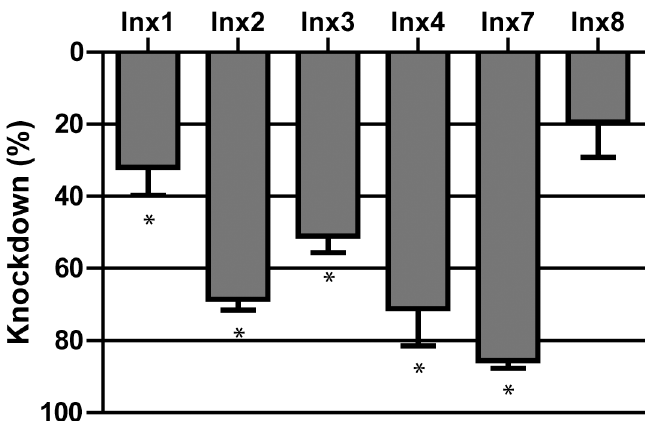
Fig 6. Knockdown efficiency in innexin dsRNA injected mosquitoes 3 days after dsRNA injection. Percent knockdown is relative to eGFP dsRNA injected control mosquitoes 3 days after injection (Fig 5). Values are means ± SEM. n = 4 replicates of 3 mosquitoes. Asterisks indicate significant knockdown compared to eGFP as determined by a Student ’ s t-test (p < 0.05).